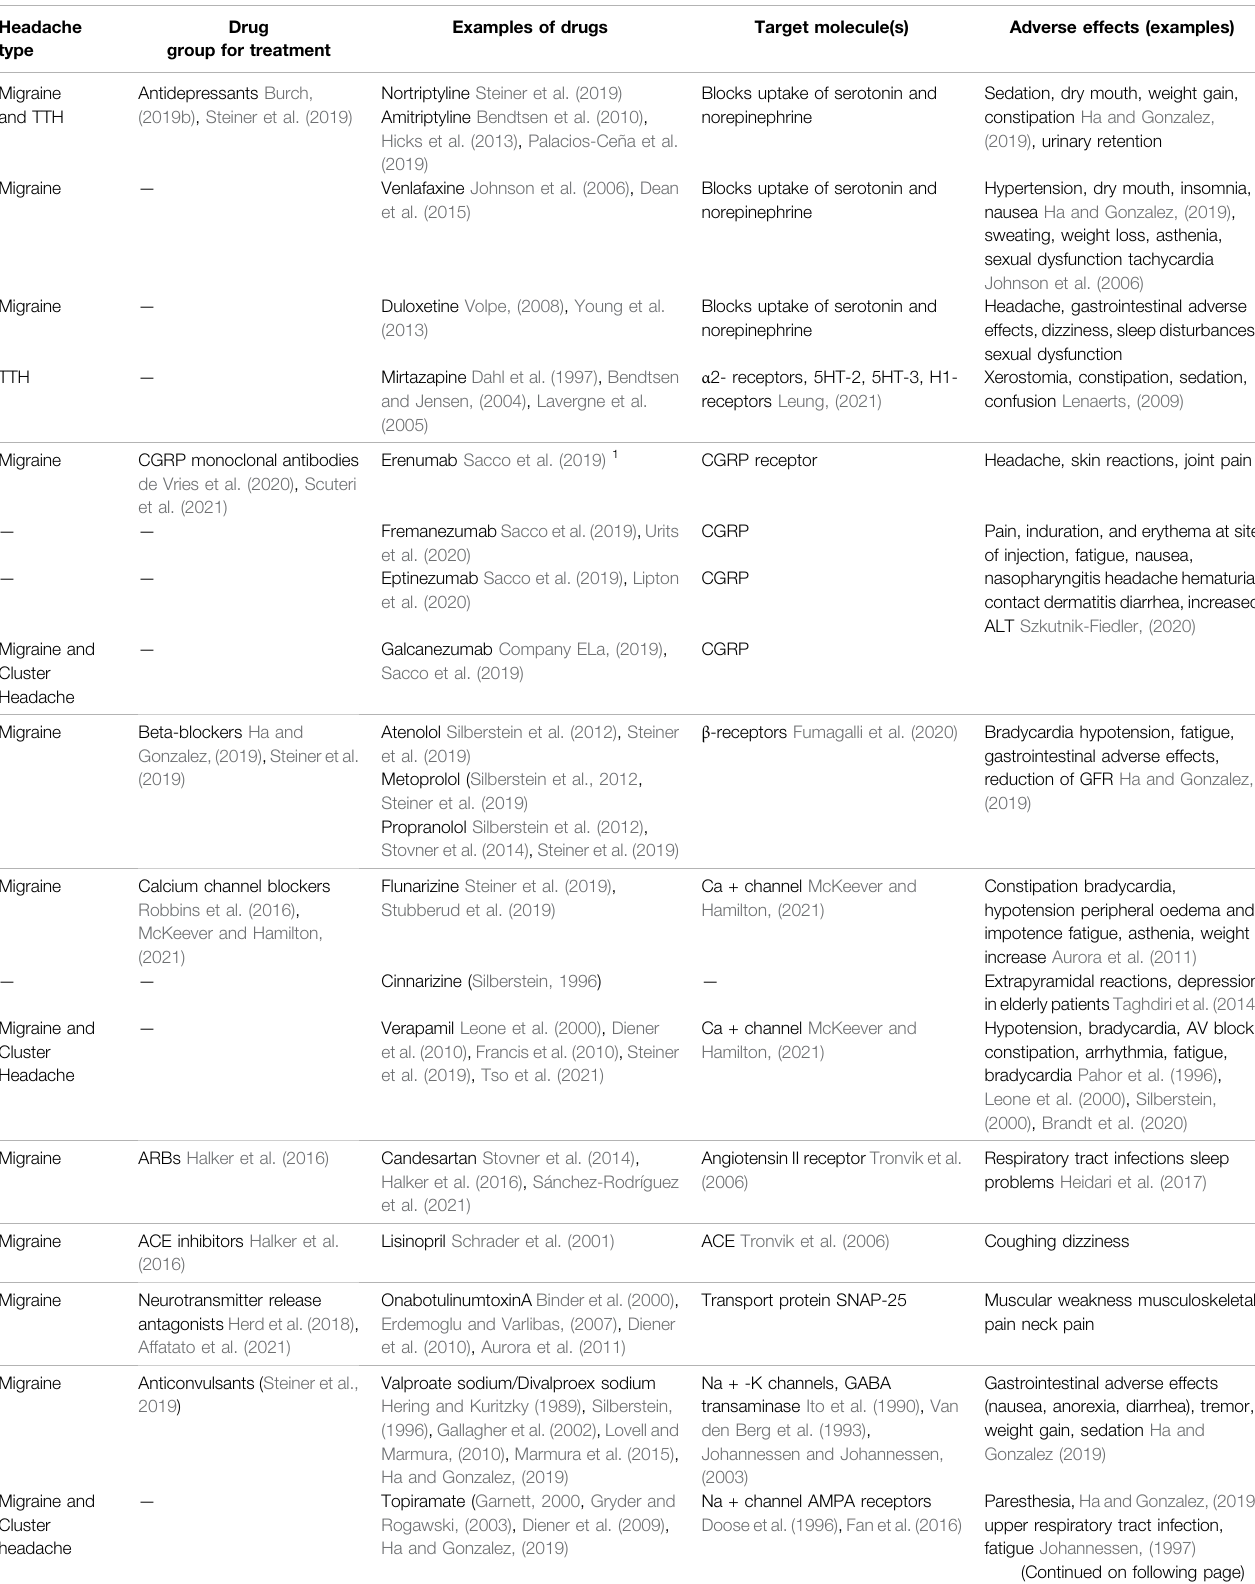
TABLE 2 | Treatment principles of primary headache disorders — treatment options for prevention. Headache